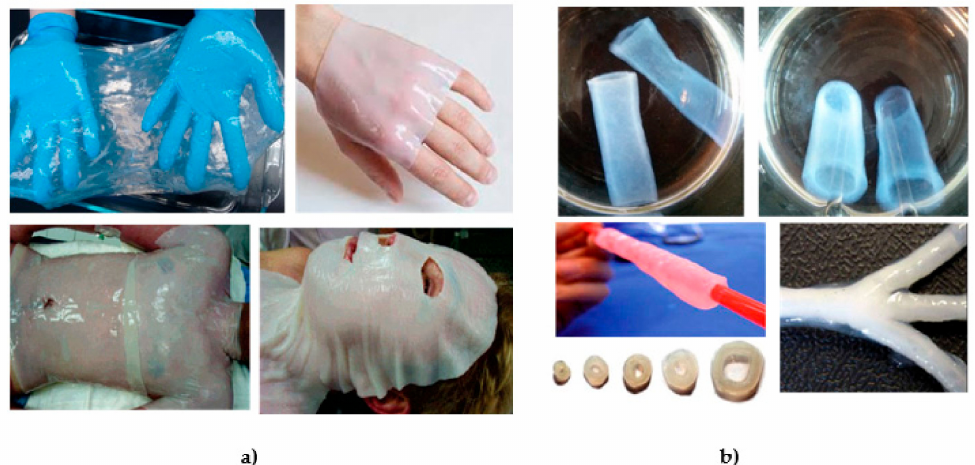
Figure 8. ( a ) BC dressings as produced and when applied on wounded torso, face and